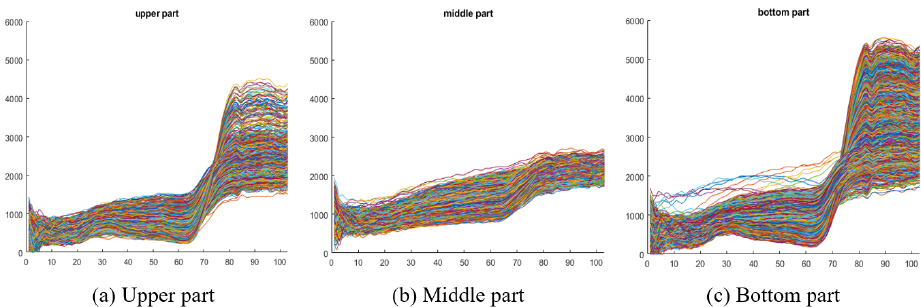
Figure 10. The spectra of the Meadows class in the PaviaU dataset: ( a ) In the upper part of the image. ( b ) In the middle part of the image. ( c ) In the bottom part of the image. They show that the spectra of the Meadows class in the middle part of the image vary significantly from the spectra of the Meadows class in other parts of the